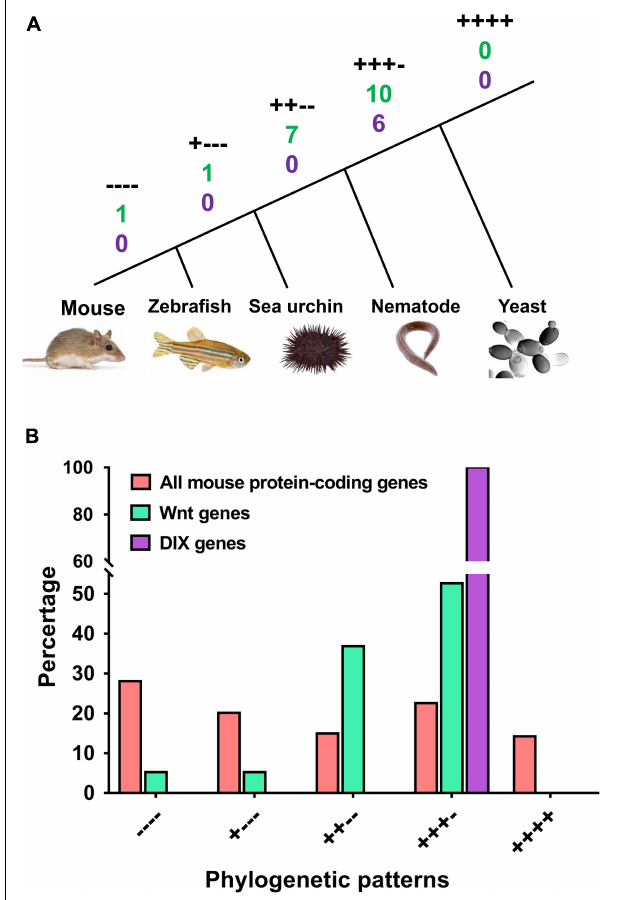
FIGURE 4 | Both the Wnt and DIX families underwent more expansion than the overall average in the evolutionarily early stage. The phylogenetic patterns of mouse Wnt and DIX genes and all mouse protein-coding genes were compared. (A) Phylogenetic relationships of five representative species, including mouse, zebrafish, sea urchin, nematode and yeast. The symbols “++++,” “+++ –,” “++ – –,” “+ – – –,” and “– – – –” denote the different phylogenetic patterns. The numbers under each label denote the quantities of Wnt (green) and DIX (purple) genes accordingly. (B) Comparison between the proportions of mouse Wnt and DIX genes and all mouse protein-coding genes in different phylogenetic patterns.